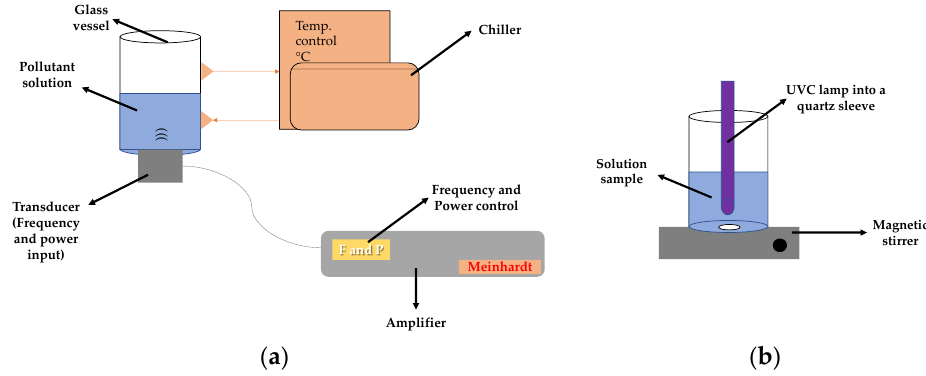
Figure 8. Scheme of the experimental setups. ( a ) Ultrasound reactor for the sono-Fenton process, in this reactor, frequency and power can be adjusted. ( b ) Reactor for the photo-treatment.